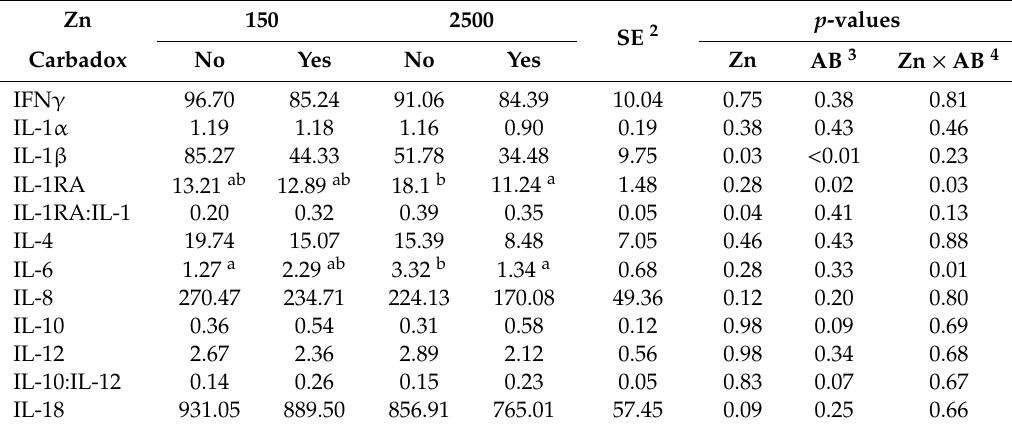
Table 2. Concentration of ileal cytokines of pigs fed diets containing a pharmacological dose of Zn and Carbadox 1 . Zn 150 2500